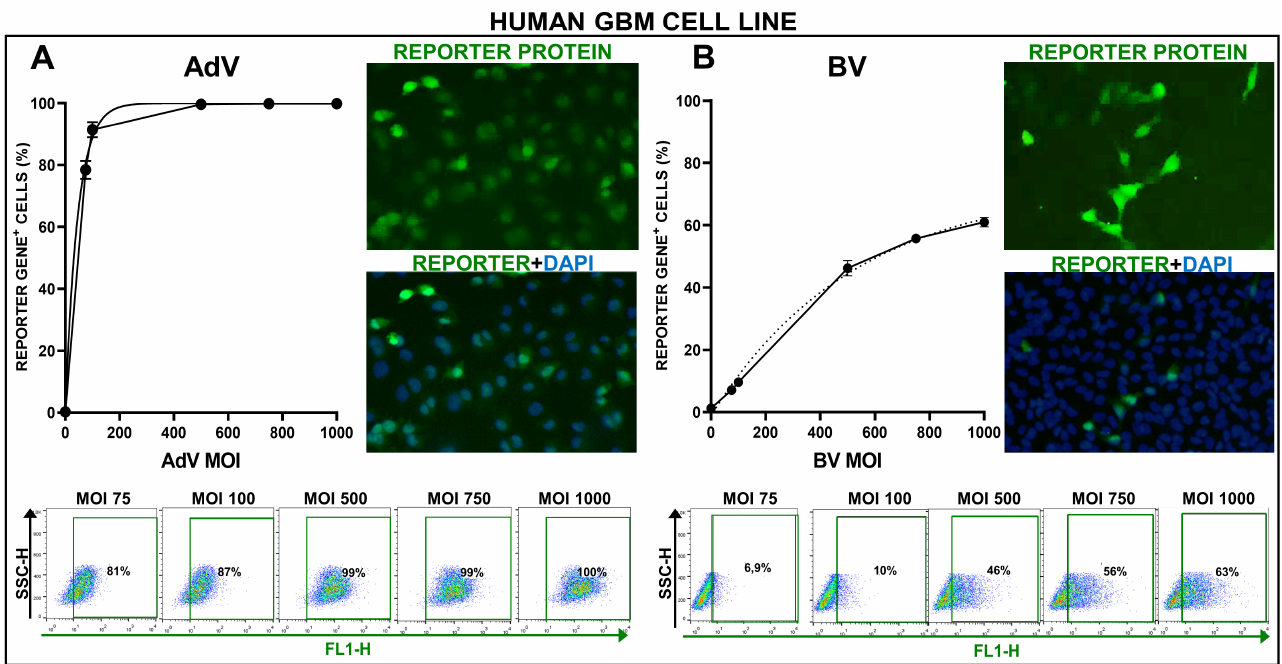
Figure 1. Transduction efficiency of AdV and BV in U251-MG human GBM cell line. U251-MG human GBM cells were incubated with an AdV ( A ) or a BV ( B ) at different MOIs, and 48 h later, transgene expression was assessed by fluorescent microscopy and quantified by flow cytometry. Representative microphotographs are shown (MOI = 750). Nuclei were stained with DAPI. Graphs show the transduction efficiency of each vector at different MOIs, as assessed by flow